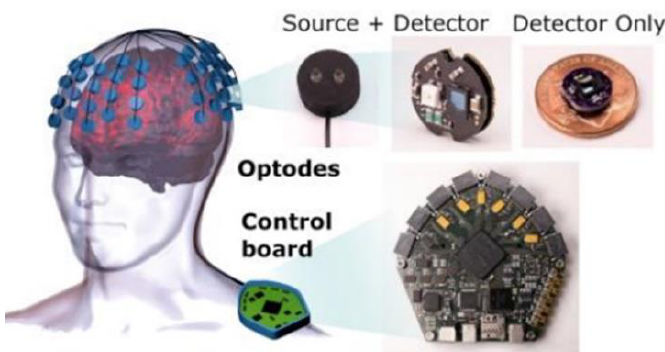
Figure 8. ninjaNIRS optodes and controller. Reproduced from reference [60].